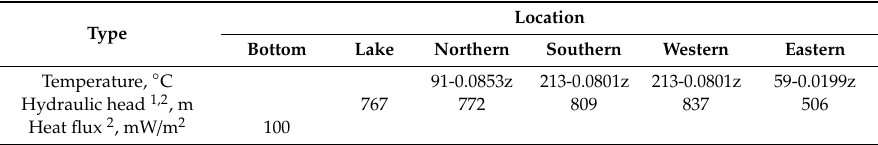
Table 3. Boundary conditions of the